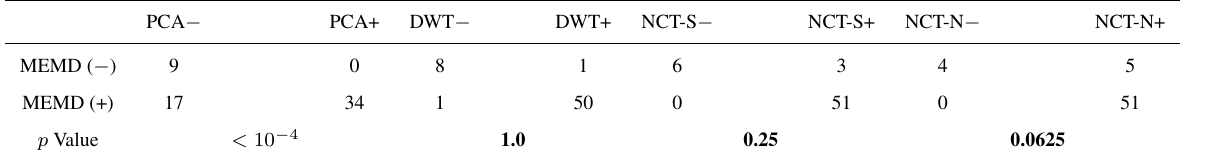
Figure 12. Quantitative analysis on multi-focus images: bar graphs of the values of quantitative measures, including the E , SF , Q AB/F and P M , shown respectively from P the top to the bottom, are obtained for MEMD-, NCT-S-, DWT-, PCA- and NCT-N-based fusion methods. Table 3. McNemar’s statistical test results for multi-focus